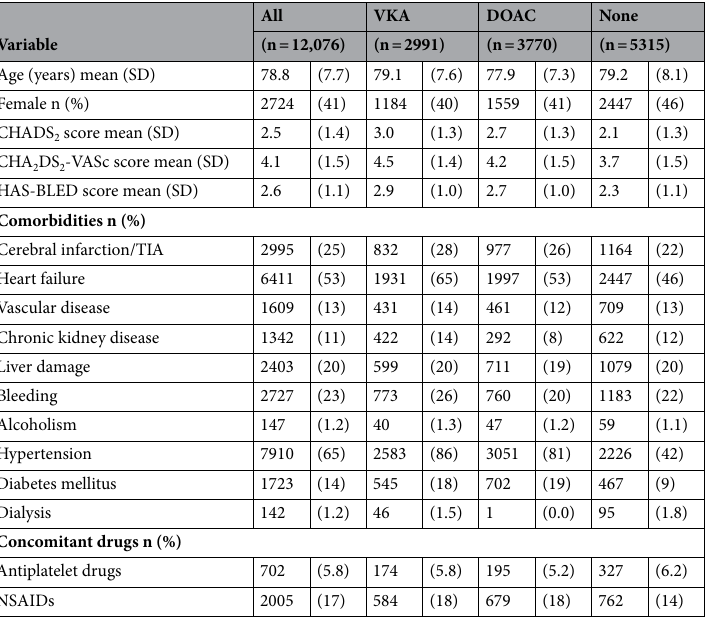
Table 1. Characteristics of atrial fibrillation (Af) patients aged ≥ 65 years (2015). * CHADS 2 score heart failure, hypertension, age ≥ 75 years, diabetes mellitus, prior cerebral infarction, or TIA(doubled). † CHA 2 DS 2 -VASc score heart failure, hypertension, age ≥ 75 years (doubled), diabetes mellitus, prior cerebral infarction or TIA (doubled), vascular disease, age 65–74 years, female sex. ‡ HAS-BLED score hypertension, renal and hepatic dysfunction, stroke, bleeding, age ≥ 65 years, concomitant antiplatelet drugs and NSAIDs, alcoholism. § TIA transient ischemic attack. II NSAIDs non-steroidal anti-inflammatory